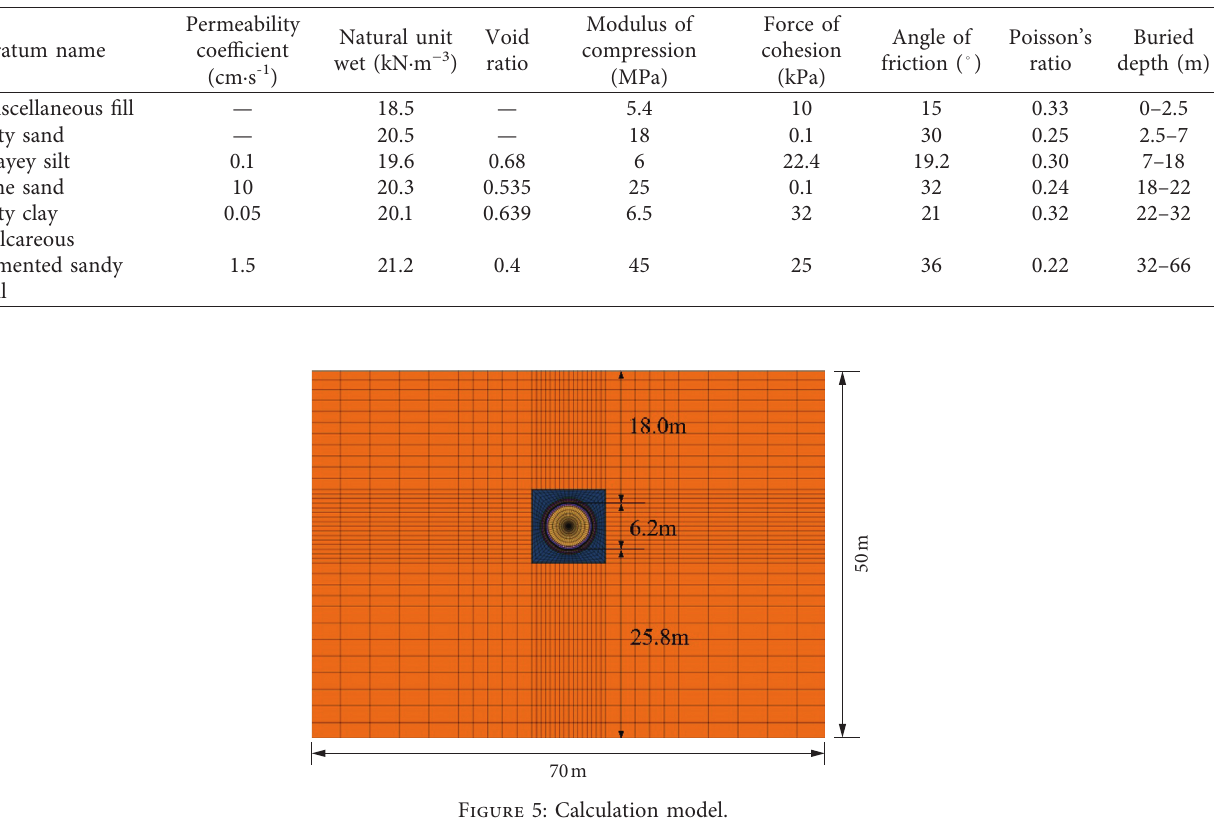
Table 8: Physical mechanics parameters for each stratum of the calculated section.